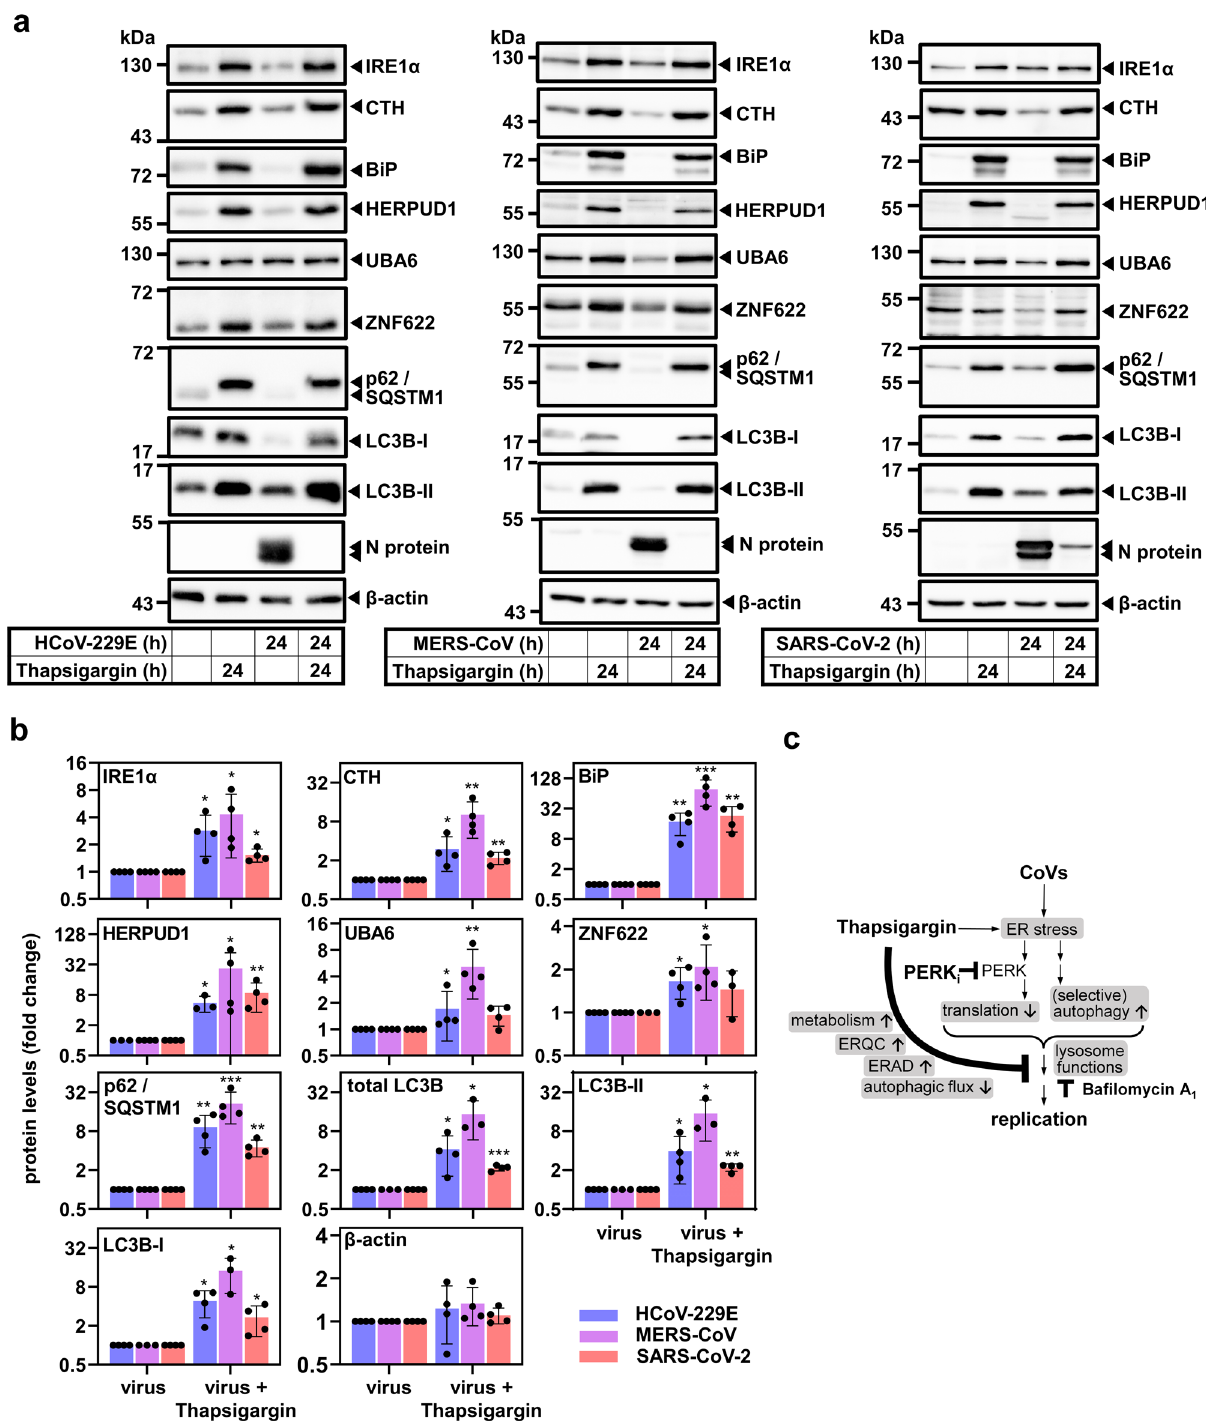
Fig. 9 Thapsigargin induces key regulators of UPR, ERQC, ERAD, and autophagy in HCoV-229E, MERS-CoV- and SARS-CoV-2-infected cells. a , b Validation of thapsigargin-induced proteins in CoV-infected HuH7 or Vero E6 cells by immunoblotting of whole-cell extracts from cells treated as indicated. BiP and IRE1 α levels are shown for comparison. a Depicts representative images and b shows quanti fi cation of four biologically independent experiments, except for HERPUD1 (HCoV-229E samples) or LC3B, LC3B-I, and LC3B-II levels from MERS-CoV-infected cells which were quanti fi ed from three experiments. Bar graphs show means± s.d.; asterisks indicate p values (* p ≤ 0.05, ** p ≤ 0.01, *** p ≤ 0.001, **** p ≤ 0.0001) obtained by two-tailed ratio-paired or Mann − Whitney t-tests. Note that LC3B-I and LC3B-II images represent different exposures of the same blot membrane (see source fi les). c Summary of the main fi ndings of our